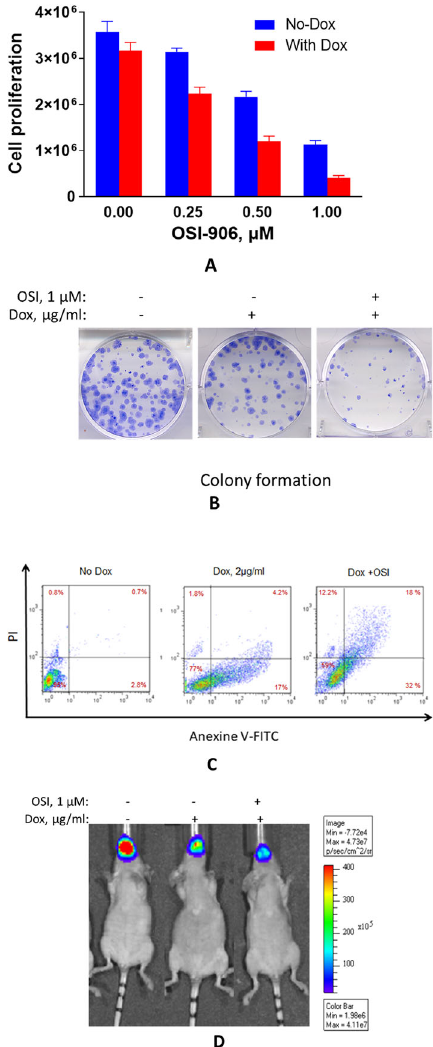
Figure 2 Downregulation of HIF ‑ 1 α suppress cell growth, colony formation, increased apoptosis, and the sensitivity of cells to IGF1R inhibition. A. Cells transfected with the silencing shRNAmir HIF ‑ 1 α were treated with 2 μ g/ml doxycycline for three days, then with OSI901 as indicated, and cell proliferation was determined at 72 h using alamarBlue. B. Colony formation assay at 14 days. C.